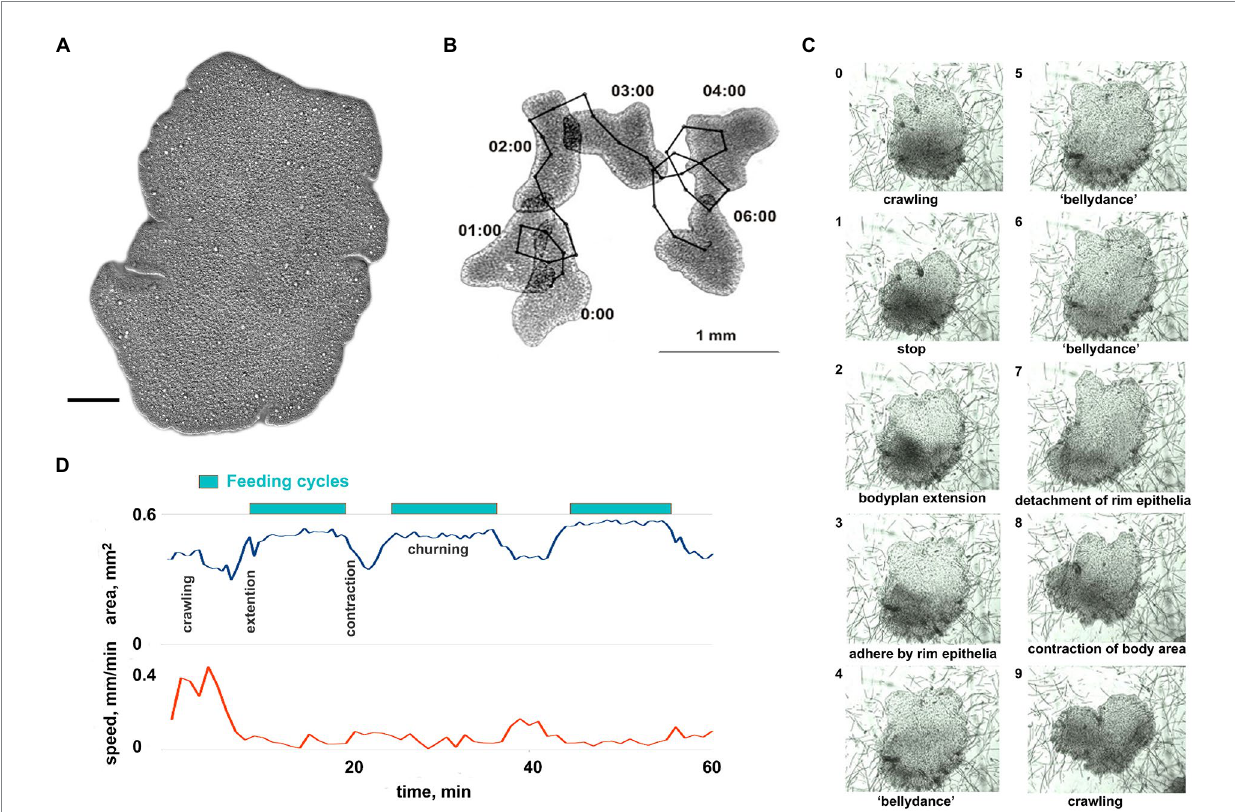
FIGURE 1 General overview of Trichoplax behavior. (A) Trichoplax adhaerens (photo) is a simple, irregularly shaped flat animal with three cell layers. Muscles, neurons, gastric cavities, or any organs are absent. Scale bar = 0.1 mm. (B) Example of Trichoplax movement and tracking. Superimposed images of an animal every 60 s are shown. Black dots mark the positions of animal centroid every 10 s. (C) The sequence of ten images shows the feeding cycle of Trichoplax on the cyanobacterial biofilm. Images were captured every minute. The animal ceases movement and expands at the beginning of each feeding cycle. The body edge is attached to a substrate, enzymes are secreted, and digested food is absorbed. Digestion is enhanced by churning movements of the central part of the animal. After a digested food is absorbed, the animal detaches its edges, contracts, and resumes movement. Each cycle takes approx. 10–20 min. (D) The plot of the body area and crawling speed (mm/min) for representative animal feeding cycles on cyanobacterial biofilm. Body area increases at the beginning of each feeding cycle and decreases at the end of each cycle. Locomotion is suppressed during each feeding